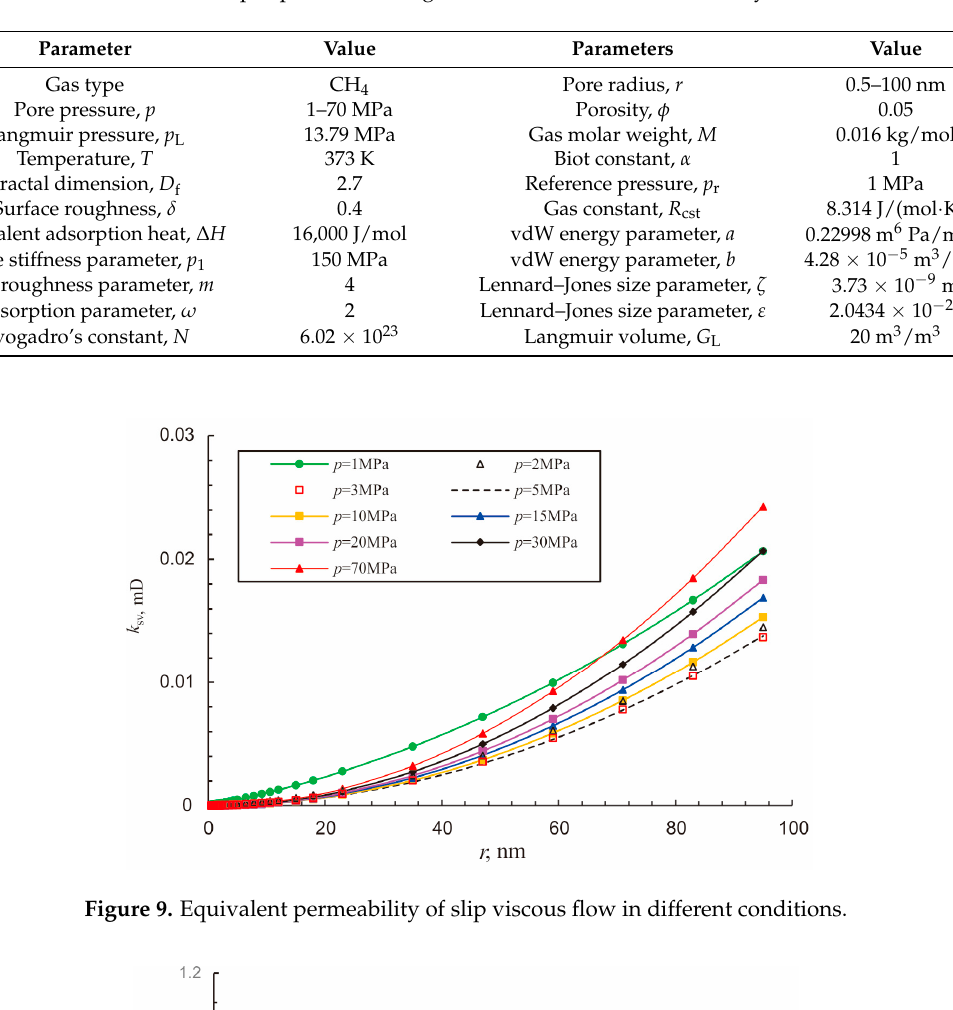
Figure 10. Contribution of slip viscous flow to total flux in different conditions.